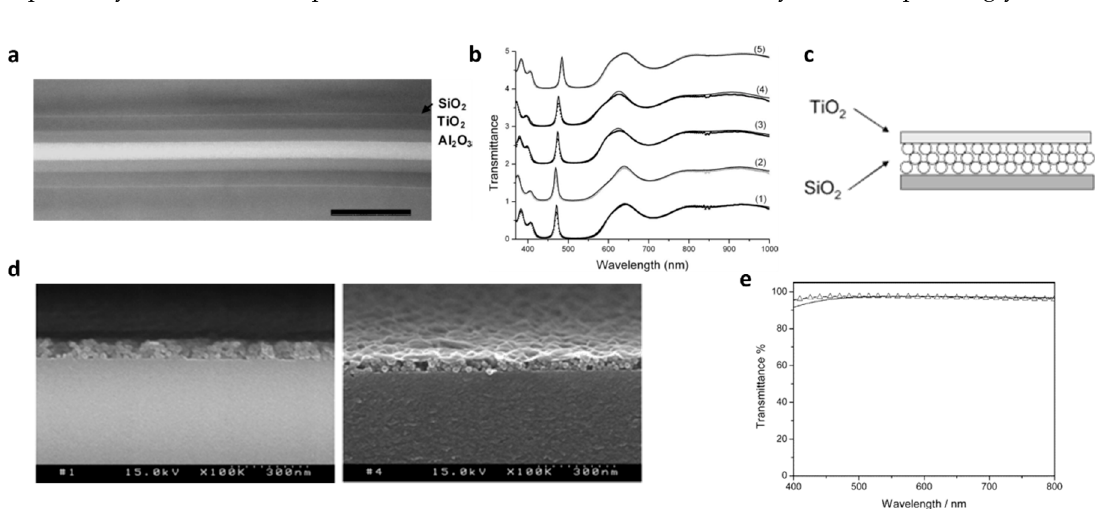
Figure 2. ( a ) TEM micrograph of a TiO 2 = Al 2 O 3 bilayer on the Si wafer. The native SiO 2 layer of ∼ 1:5 nm can be observed. The scale bar is 200 nm; ( b ) Transmittance spectra of the multilayer coatings for narrow-bandpass filters of the five dichroic filters. The spectra are offset by one for clarity. The dotted curves correspond to the experimental data, and the plain curves correspond to the calculated spectrum. The bandpass wavelength is shifted from 469 to 485 nm (Adapted with permission from [35]. Copyright 2009, The Optical Society); ( c ) Schematic view of double-layered TiO 2 –SiO 2 with antireflective properties; ( d ) Cross-sectional electron micrographs of (PDDA/SiO2) 6 and (PDDA/SiO 2 ) 6 /(PDDA/nanosheet) 6 multilayer films after calcination at 500 °C, respectively; ( e ) Calculated (triangles) and measured (dotted line) normal incidence transmission spectra of a TiO 2 –SiO 2 double-layered film prepared from a (PDDA/SiO 2 ) 6 (PDDA/nanosheet) 9 multilayer assembly. The calculation was based on a 6.5 nm thick TiO 2 /55 nm thick SiO 2 double-layered structure. (Adapted with permission from [36], Copyright 2006, American Chemical Society).